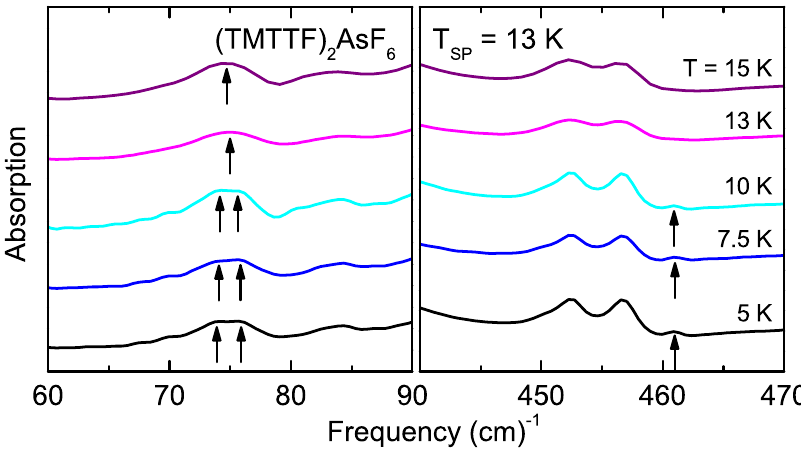
Figure 25. The absorption spectra exhibit the temperature-development of the 75 cm − 1 lattice mode in (TMTTF) AsF on the left side. In the right panel, a weak band develops at 2 6 461 cm − 1 that might be a satellite of the double structure seen at 452 and 457 cm − 1